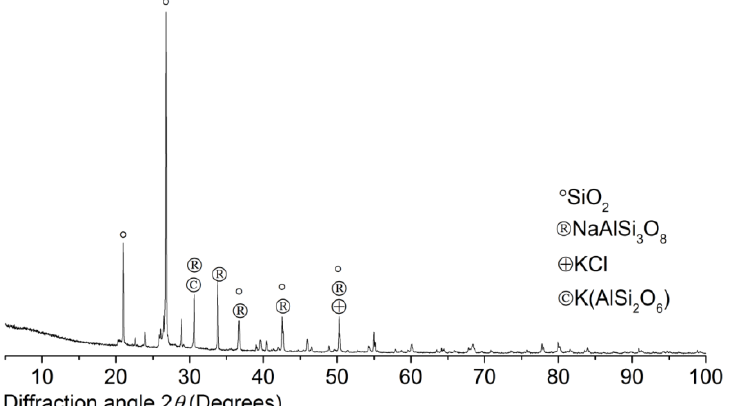
Figure 5. XRD patterns of sea sand.